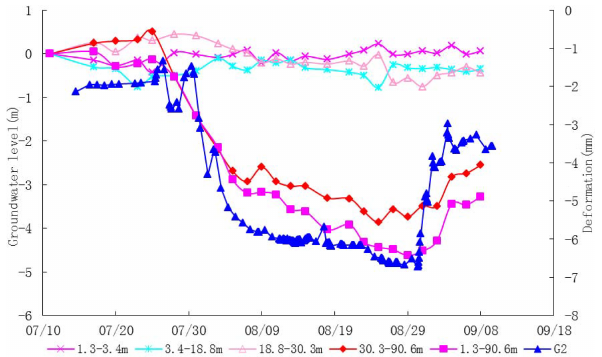
Figure 6. The observation data of pore water pressure (it has been converted to water level, and the coded data KY represents the pore water pressure measurements at different depths).